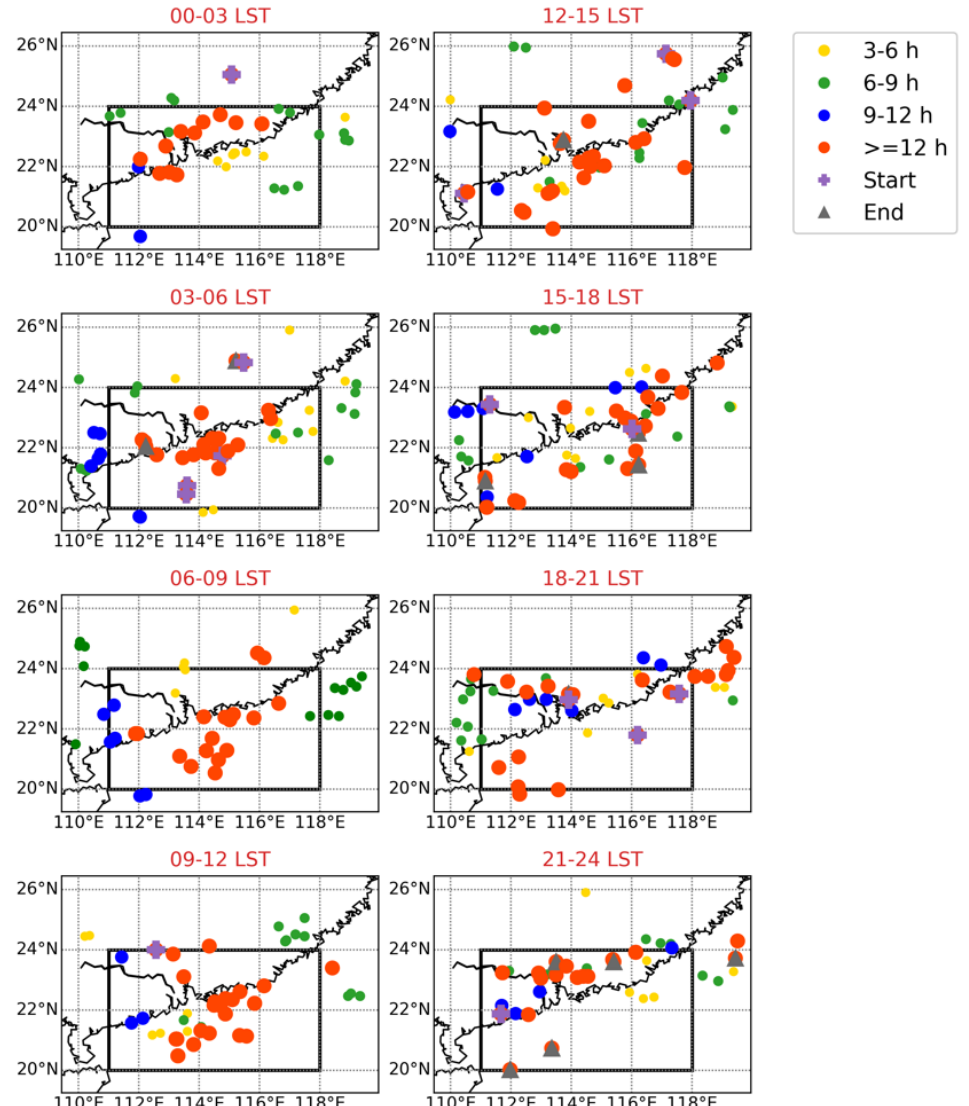
Figure 11. Identified MCSs are classified into four categories, as denoted by different markers, according to their duration. The points represent convection centers collected from each frame. For the strong convections that last over 12 h, their start and end points are further marked with a purple cross and gray triangle, respectively.